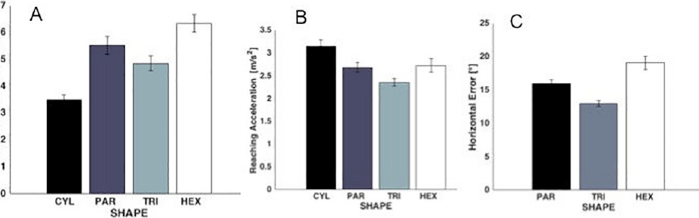
Fig 4. Significant shape effects: Means ± SE are reported. Shapes are reported in the presentation order. The horizontal error (C), is cannot be defined for CYL.